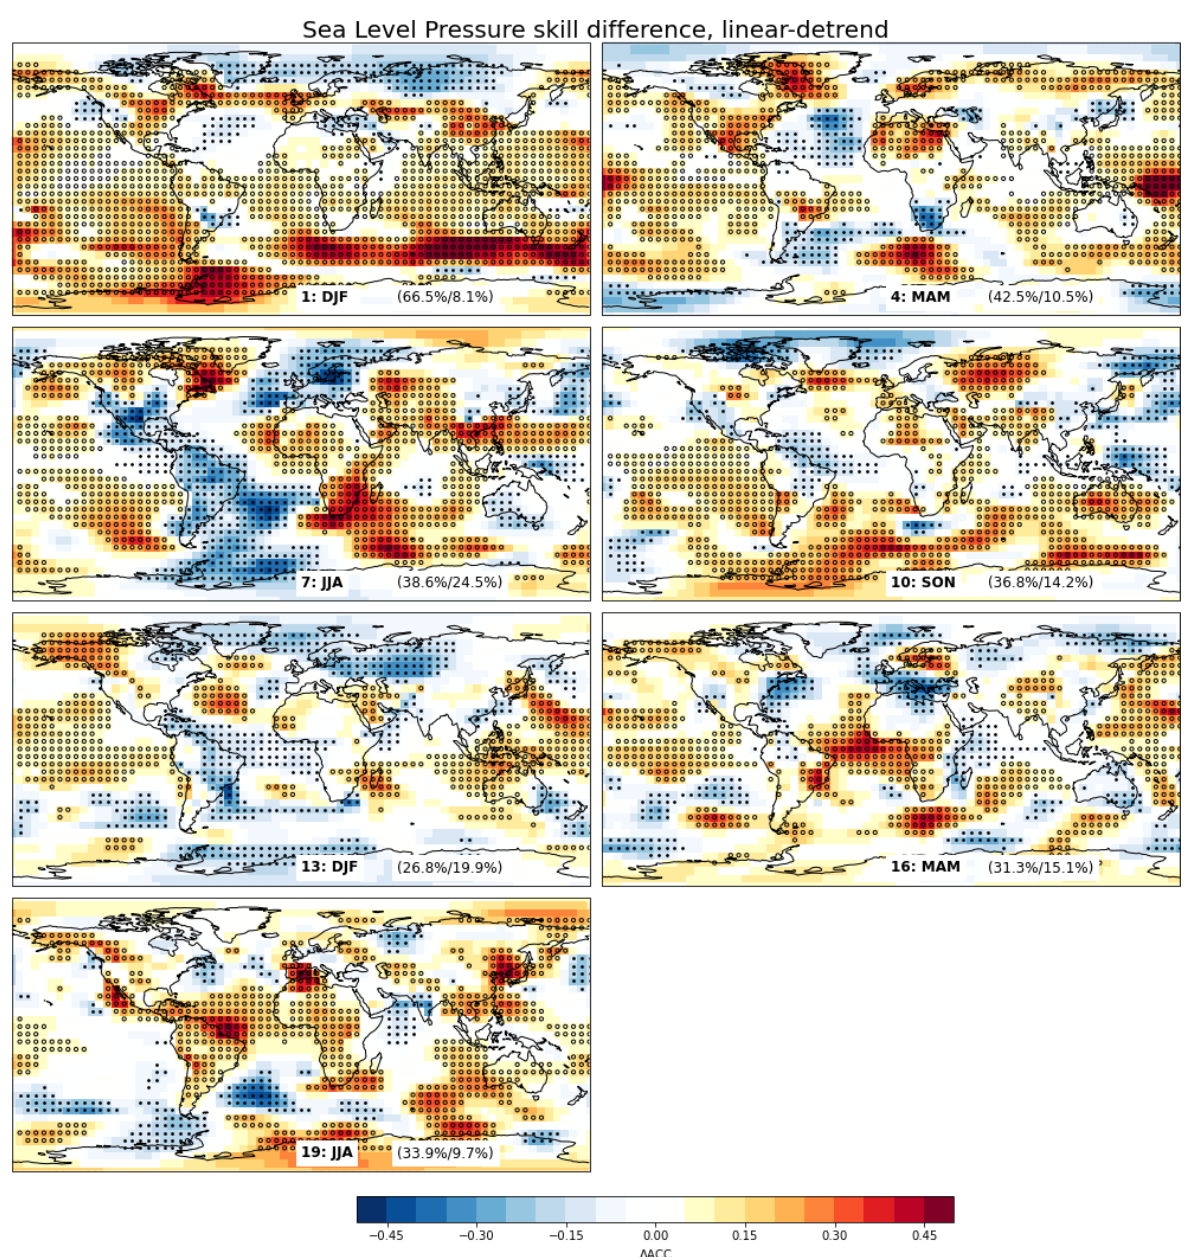
Figure B6. Difference in ACC skill for sea level pressure between SMYLE-NOV and the mean of the 20-member skill score distribution from DPLE-NOV. Here, both hindcast sets use identical verification windows (corresponding to start dates spanning 1970–2017). Open and filled circles indicate significantly higher and lower ACC in SMYLE-NOV, respectively (corresponding to SMYLE-NOV skill falling above the 90th or below the 10th percentile of a 100-member distribution of 20-member DPLE-NOV scores). Values in parentheses give the percentage of global surface area (within 80 ◦ S–80 ◦ N) where there is significant skill increase/decrease.